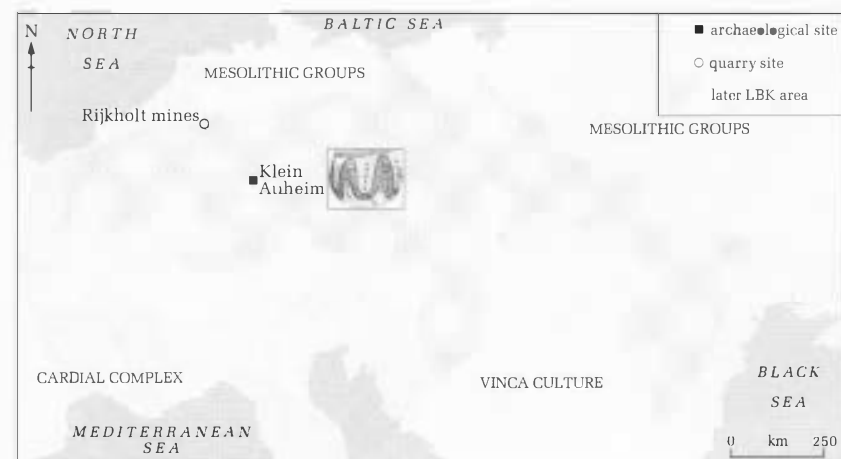
Figure 1 Distribution across Europe of settlement sites of the Linearbandkeramik